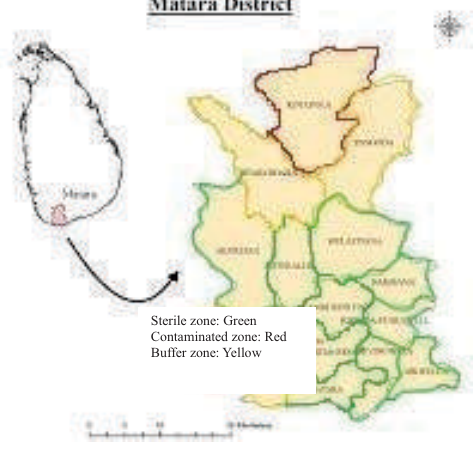
Figure 4: Depiction of the